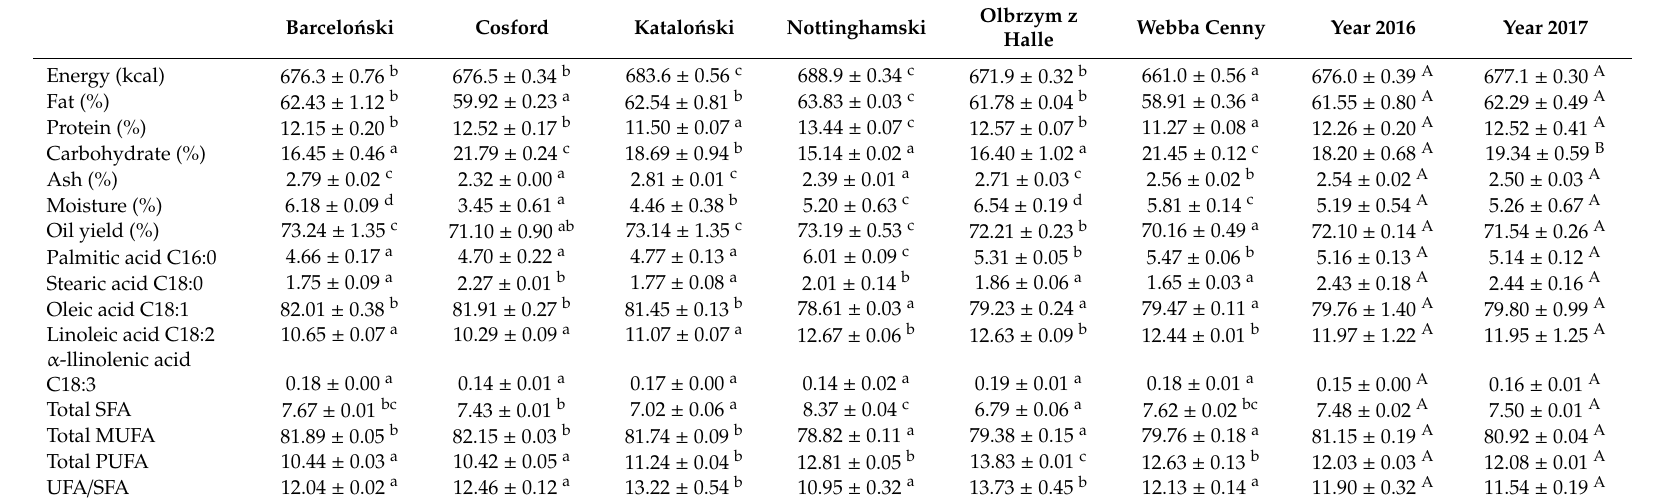
Table 3. Kernel composition of six hazelnut cultivars grown in